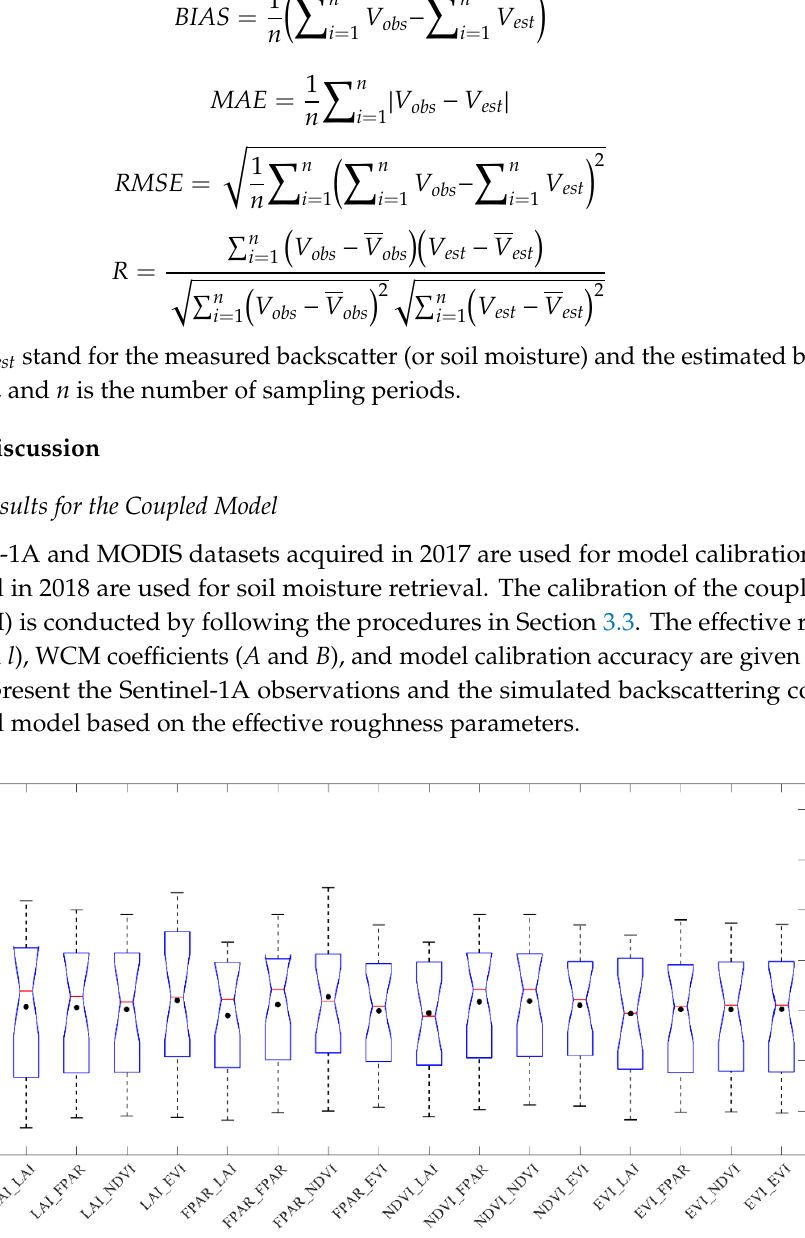
Figure 5. Backscattering coefficient simulated from the coupled model with the different vegetation combinations. The boxplots show the median (red horizontal line), mean (black cycle), 25th and 75th percentiles (top and bottom of the blank box, respectively), and the outlier ranges (edges of the top and bottom whiskers). The “LAI_FPAR” indicates that the V 1 and V 2 are characterized by the LAI and FPAR,